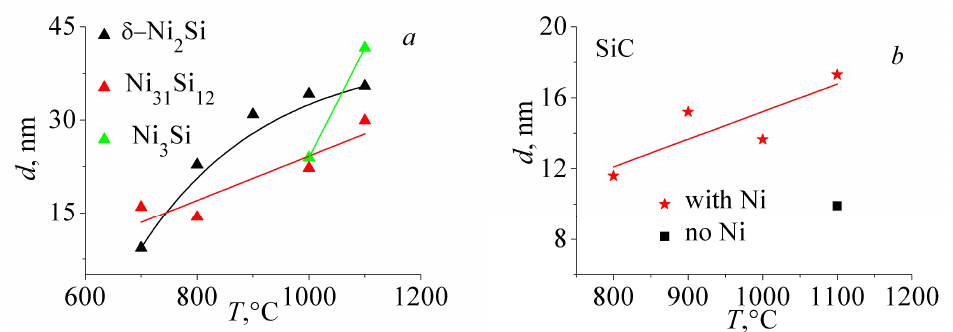
Figure 6. Temperature dependence of crystallite size for phases: ( a ) δ -Ni 2 Si; Ni 31 Si 12 ; Ni 3 Si; ( b ) β